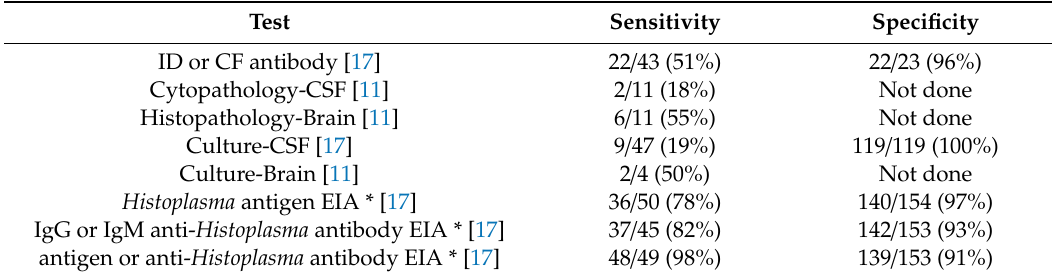
Table 2. Diagnostic tests in CSF for Histoplasma